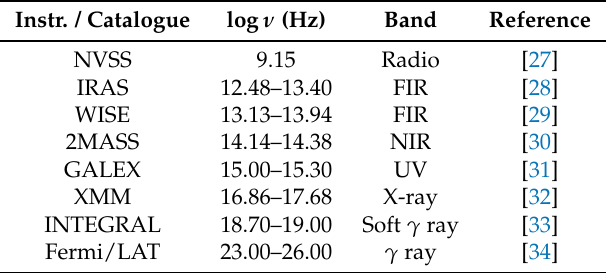
Table 1. Data sources for the selection of multiple-wavelength spectral energy distribution (SED) points.